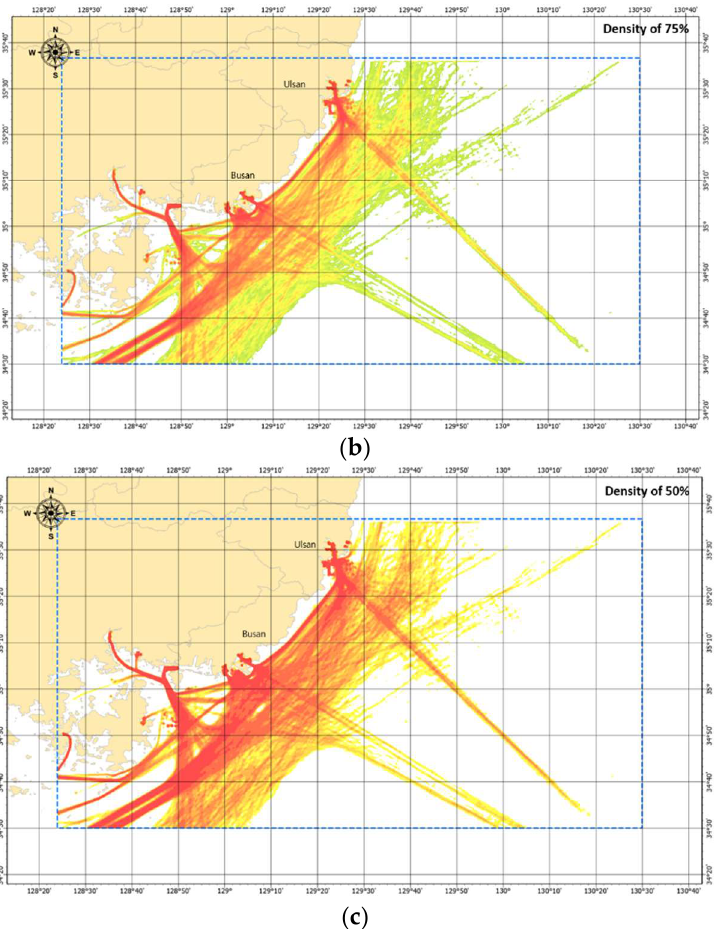
Figure 4. As the result of analysis of maritime traffic density in sea Area 7, the sea area with the highest traffic volume in Korea ( a ) shows 90% of the total sea traffic volume and shows that all sea areas are covered ( b ) of the total sea traffic volume. The result shows 75%, and the result is relatively less than 90%. ( c ) The result shows 50% of the total maritime traffic and shows the main maritime routes.